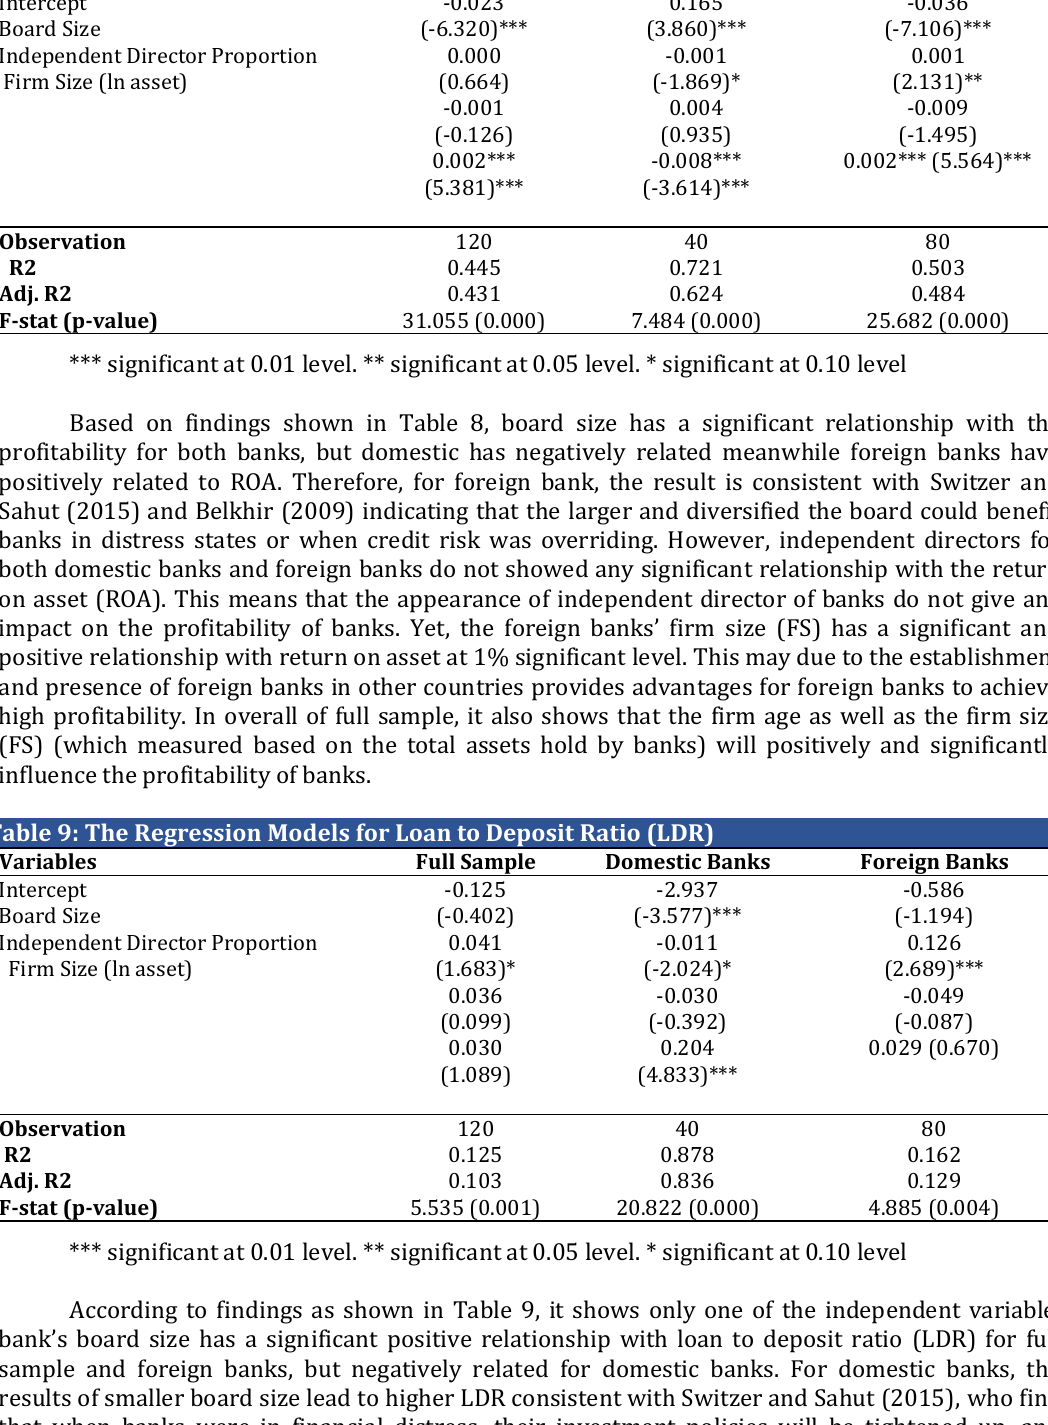
Table 8: The Regression Models for Return on Asset (ROA) Variables